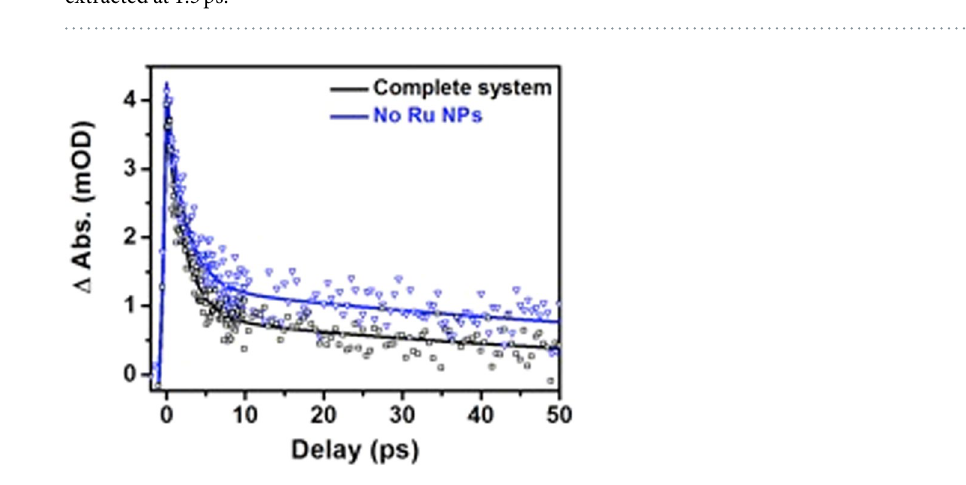
decay functions with τ 1 = 2.6 ps (65%) and τ 2 = 92 ps (35%) ( <τ> = 34 ps), which endorses ultrafast recombina- tion dynamics and accordingly good connectivity between two sites. By adding Ru NPs one expects a suppression of the recombination pathway as electrons are expected to transfer from TiO 2 to the Ru 4d empty states, leading to